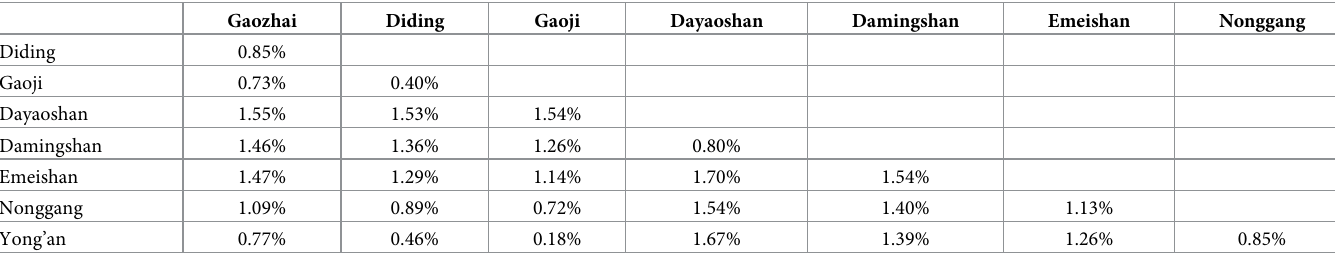
Table 1. Mean genetic distances of Tonkinacris sinensis between populations. Gaozhai